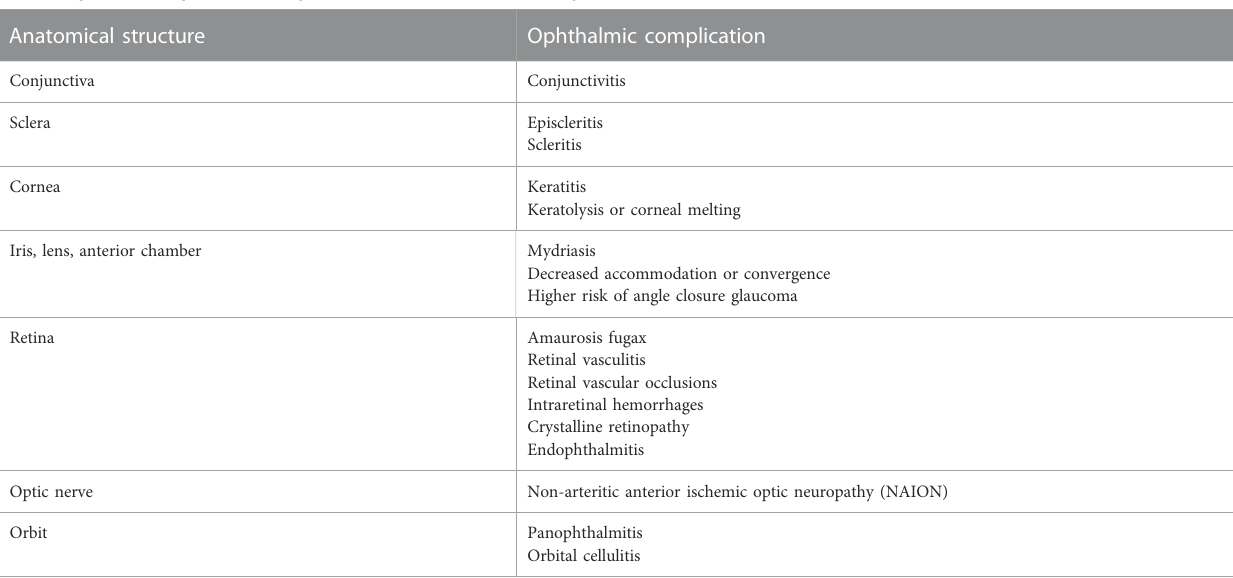
TABLE 1 Spectrum of ophthalmic complications associated with methamphetamine